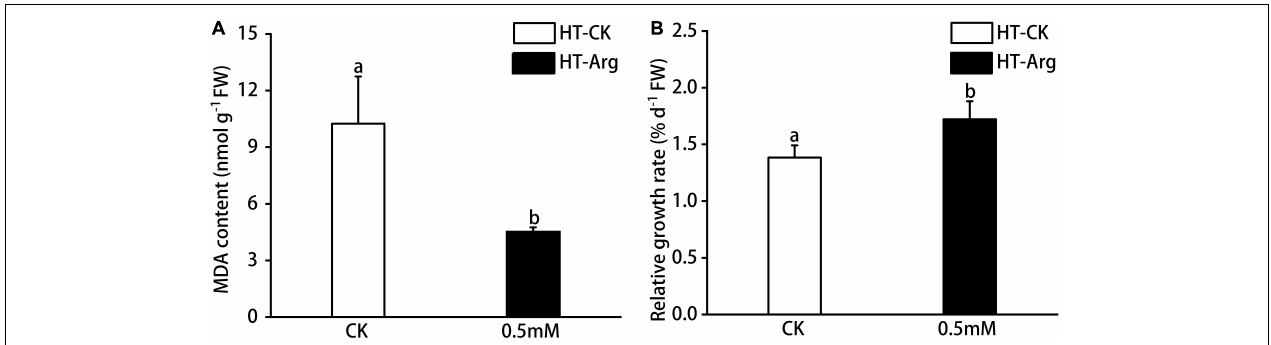
FIGURE 1 | Effect of L-arginine with 0.5 mM concentration on G. lemaneiformis under heat stress after 7 days. (A) Malonaldehyde (MDA) content and (B) relative growth rate (RGR). Data are means ± SD ( n = 3), and different letters between different concentrations of arginine treatments indicate a significant difference ( p < 0.05).